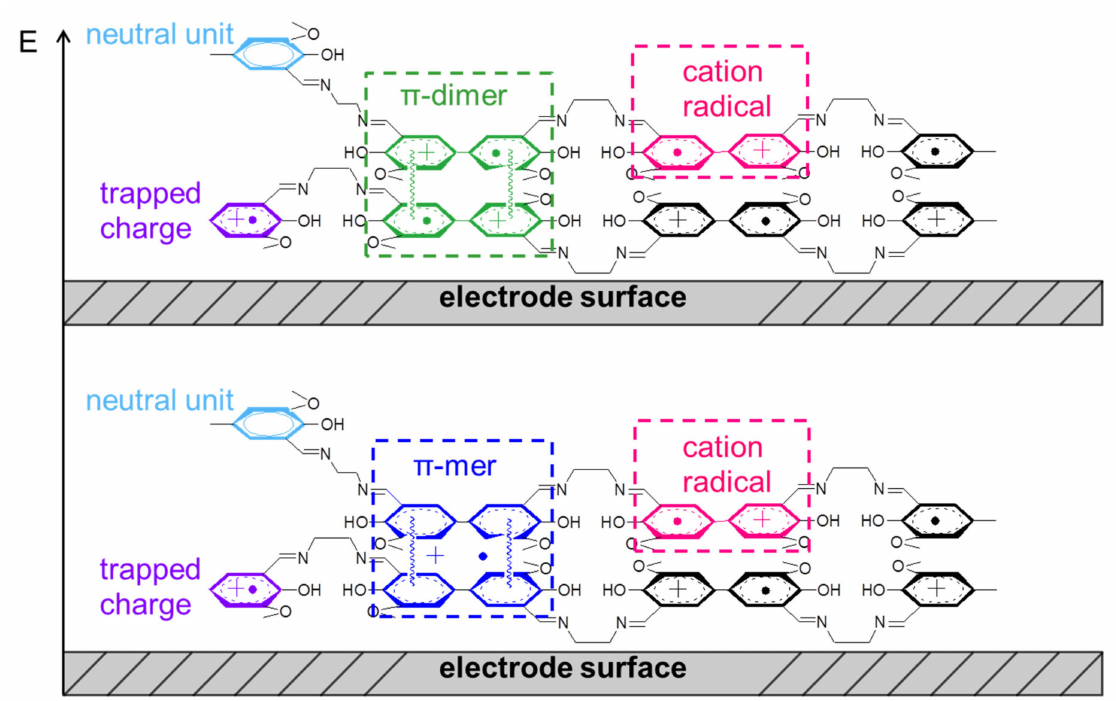
Scheme 6. Schematic representation of the polymer film poly-H 2 (3-MeOSalen) at different doping levels. At a low doping level the main charge carriers in the film are cation radicals (pink) and π -mer structures (blue). With an increase in the doping level, the conversion of π -mers (blue) to π -dimers (green) occurs. Defects in the polymer structure such as “trapped” charge (purple) and neutral units (baby blue) are not involved in redox processes. The deviation of monomeric units from planarity was ignored for